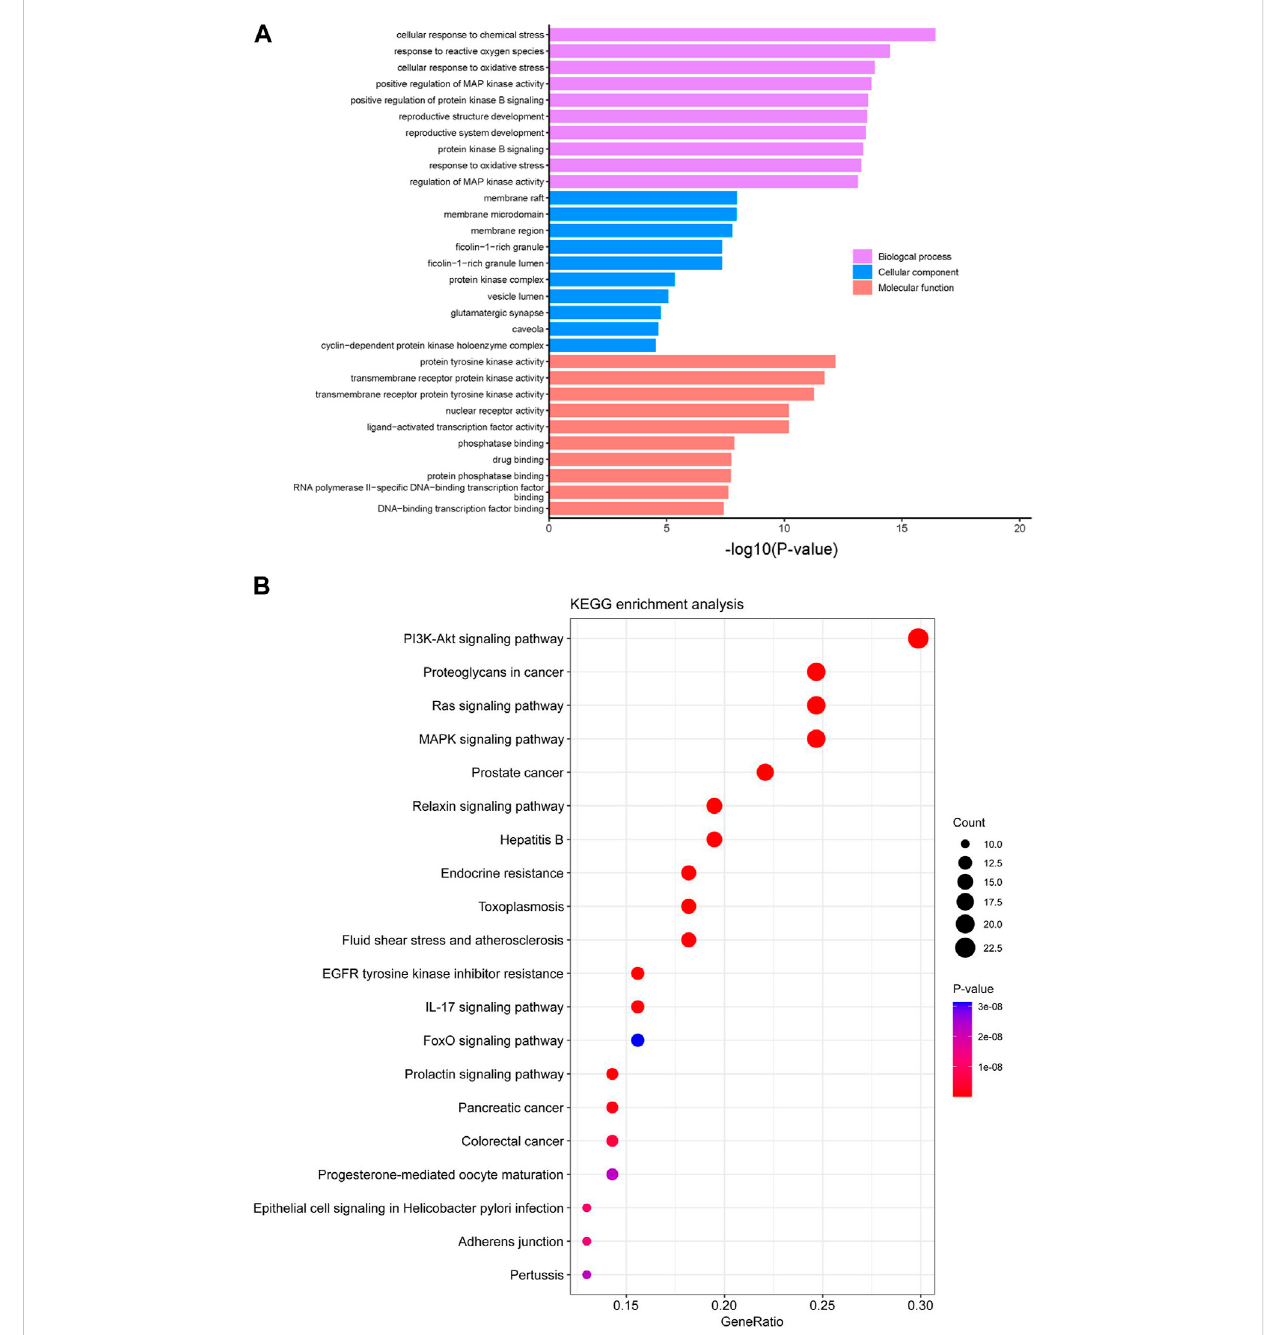
FIGURE 7 GO and KEGG pathways enrichment analysis. (A) GO enrichment analysis of the 81 predicted targets of compound 6e in the treatment of oral epidermoidcarcinoma. (B) Top20ofKEGGpathwayenrichmentanalysisofthe81predictedtargetsofcompound 6e inthetreatmentoforalepidermoid